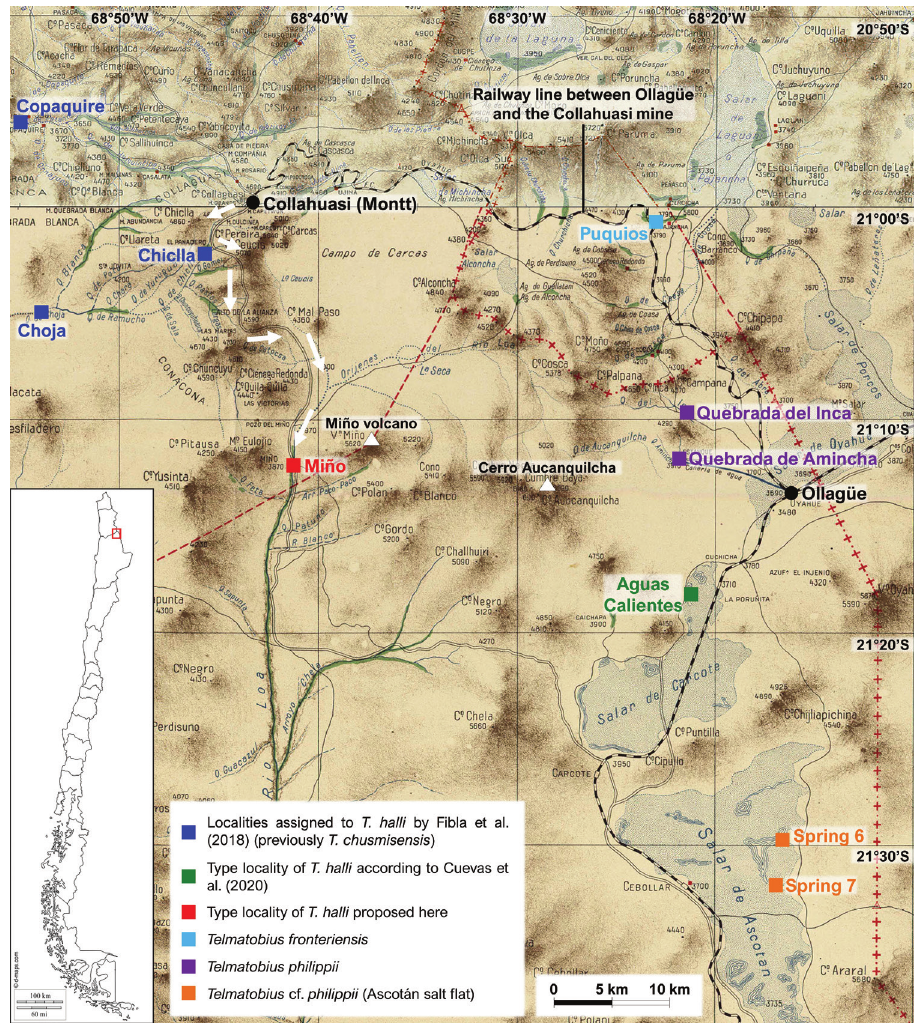
Figure 1. Upper area of the Loa River and surroundings, showing the location of populations recently assigned to Telmatobius halli , its type locality according to this study and other Telmatobius populations near Ollagüe. The railway line that connected Ollagüe with the Collahuasi mine (to the Montt station) and the dirt road that connected the Collahuasi mine and Chiclla with Miño (white arrows) are indicated. Note that the road continues from Miño to the Carcote salt flat. The background map was constructed by joining two maps published by the Comisión Chilena de Límites in